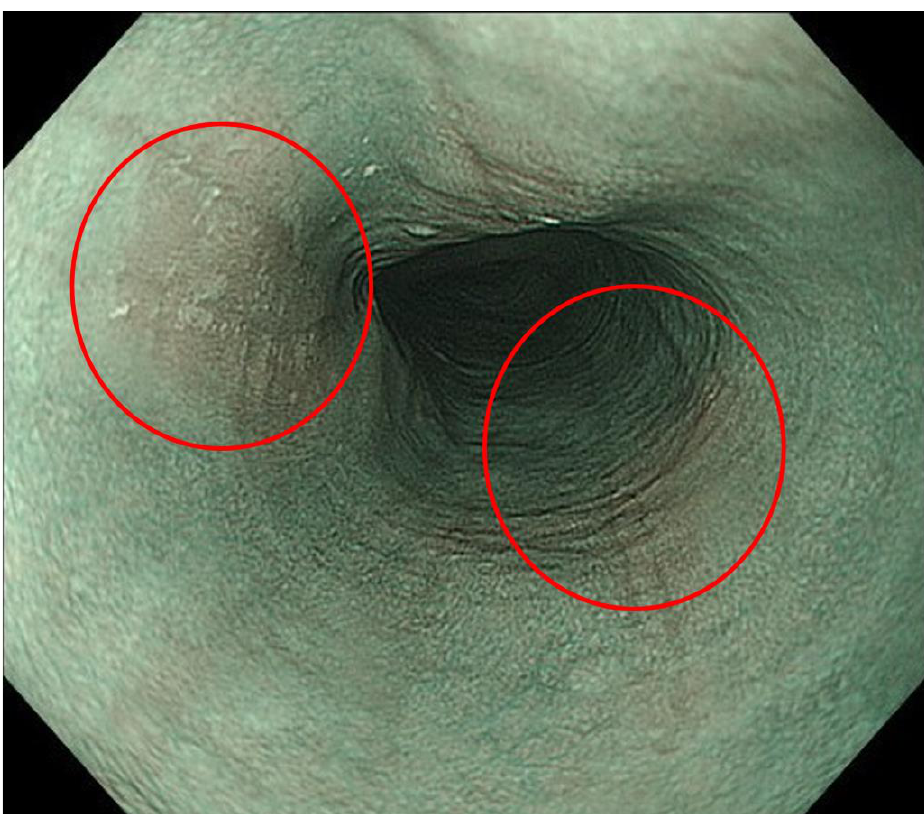
Figure 8. Beige mucosa was seen in narrow-band imaging. Beige mucosa could be observed in narrow-band imaging (red circles), and this finding made the detection of eosinophilic esophagitis easier than furrows in white light imaging in this case.